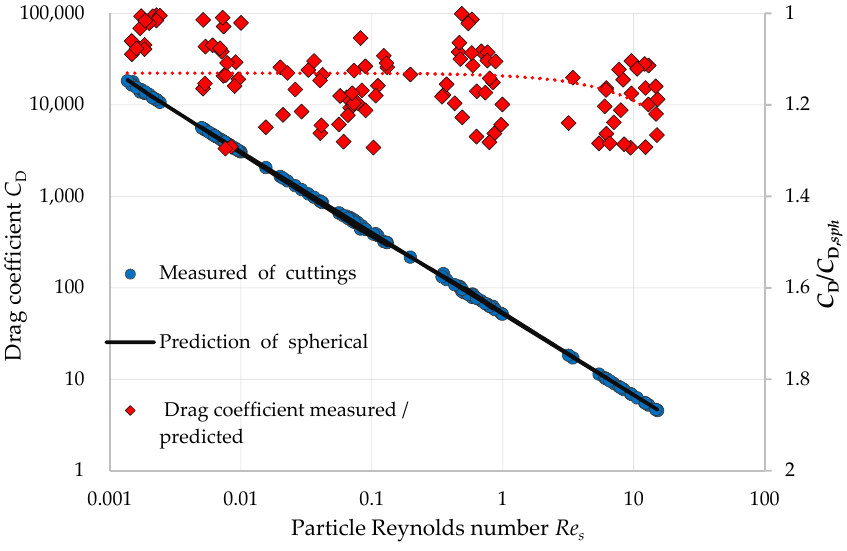
Figure 11. C D - Re s relationship of 224 shale cutting data.